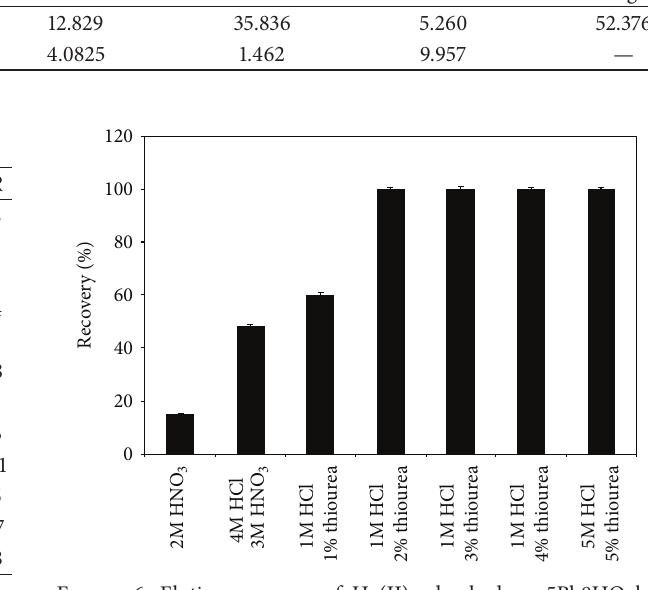
Figure 6: Elution recovery of Hg(II) adsorbed on 5Ph8HQ by column method using different types of eluents. Conditions: [Hg 2+ ]: 2 ng mL −1 , volume: 50mL, pH: 4, and eluent volume: 10mL. Bars represent standard deviation for two replicates.